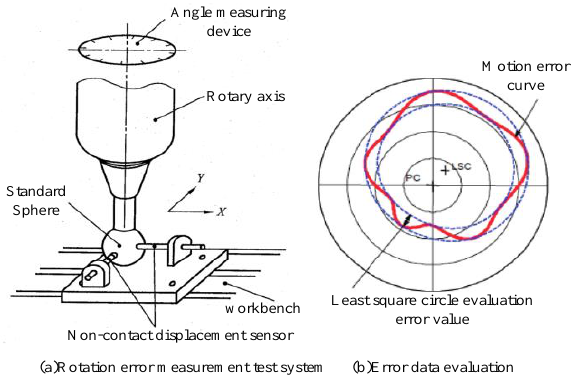
Figure 2. Measurement system and data evaluation of rotary error.